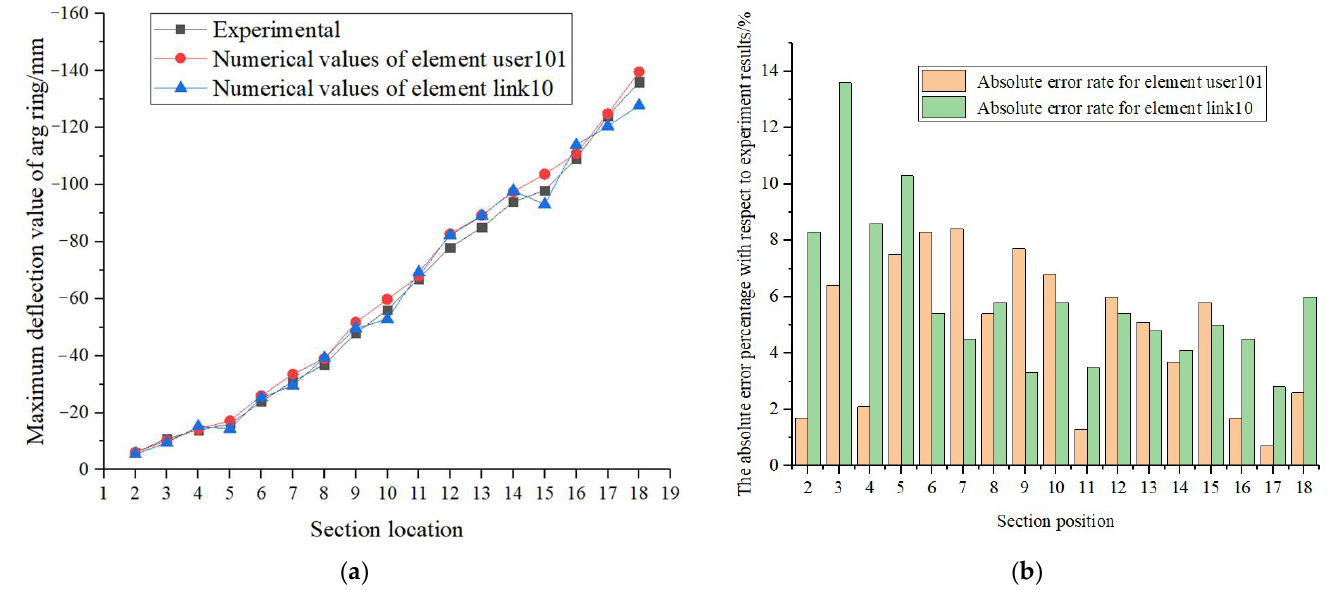
Figure 11. Comparison of maximum deflection values for each section of the arch ring: ( a ) Comparison of different elements with experimental values; ( b ) Comparison of the absolute error of different elements.